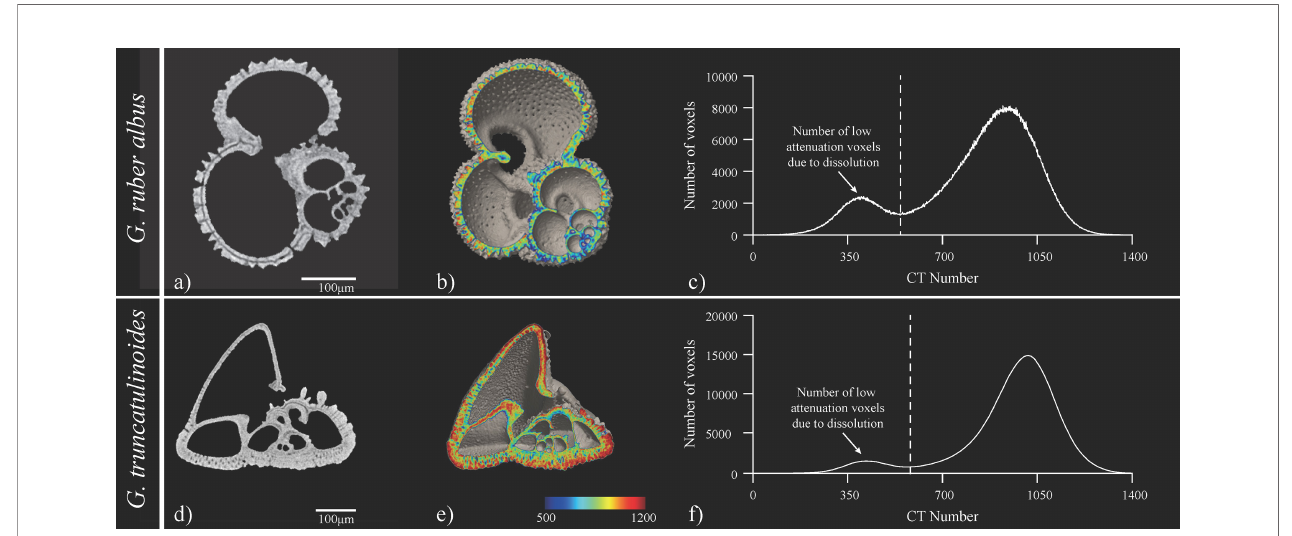
FIGURE 9 | Illustration of XMCT data from site 9 (RC24-11). (A) is a tomographic image, (B) a cross-sectional isosurface image from CT image analysis software and (C) the CT number histogram of G. ruber albus and for G. truncatulinoides respectively characteristic (D) tomographic image, (E) cross-sectional isosurface image from CT image analysis software and (F) the CT number histogram. In (A) dissolution (higher Mg-calcite) is evident in the penultimate chamber as a grey gap in the middle of the shell wall but juvenile cambers are retained. In (D) similar grey gaps are present in the smaller chambers that are secreted in warmer waters can be observed for G. truncatulinoides as well. The mild bimodality of (C) at the low attenuation region of the histogram denote only minor